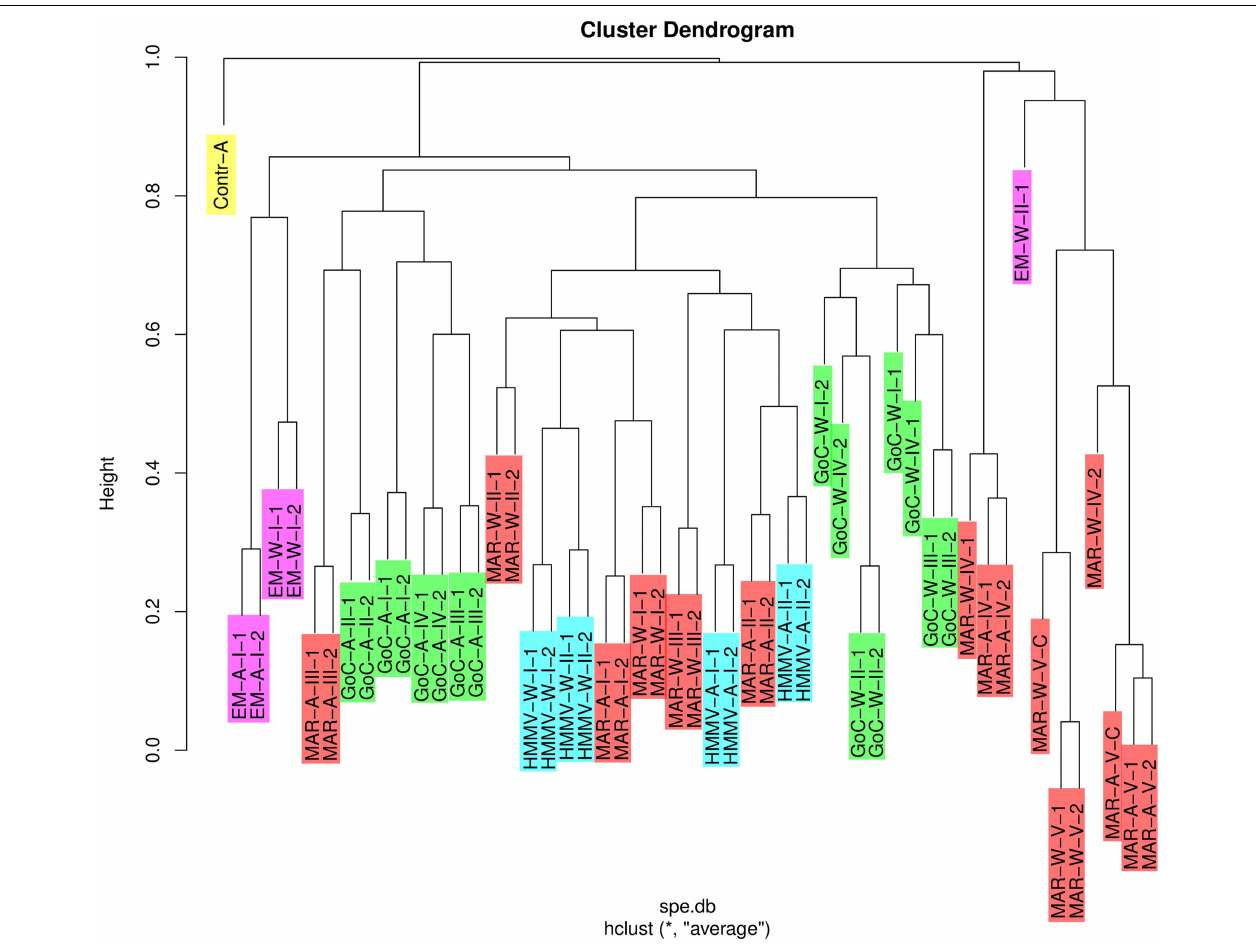
FIGURE 4 | Dendrogram for average agglomerative clustering generated in R (R Development Core Team, 2013) using Unweighted Pair-Group Method with arithmetic Average (UPGMA) on a Bray-Curtis distance